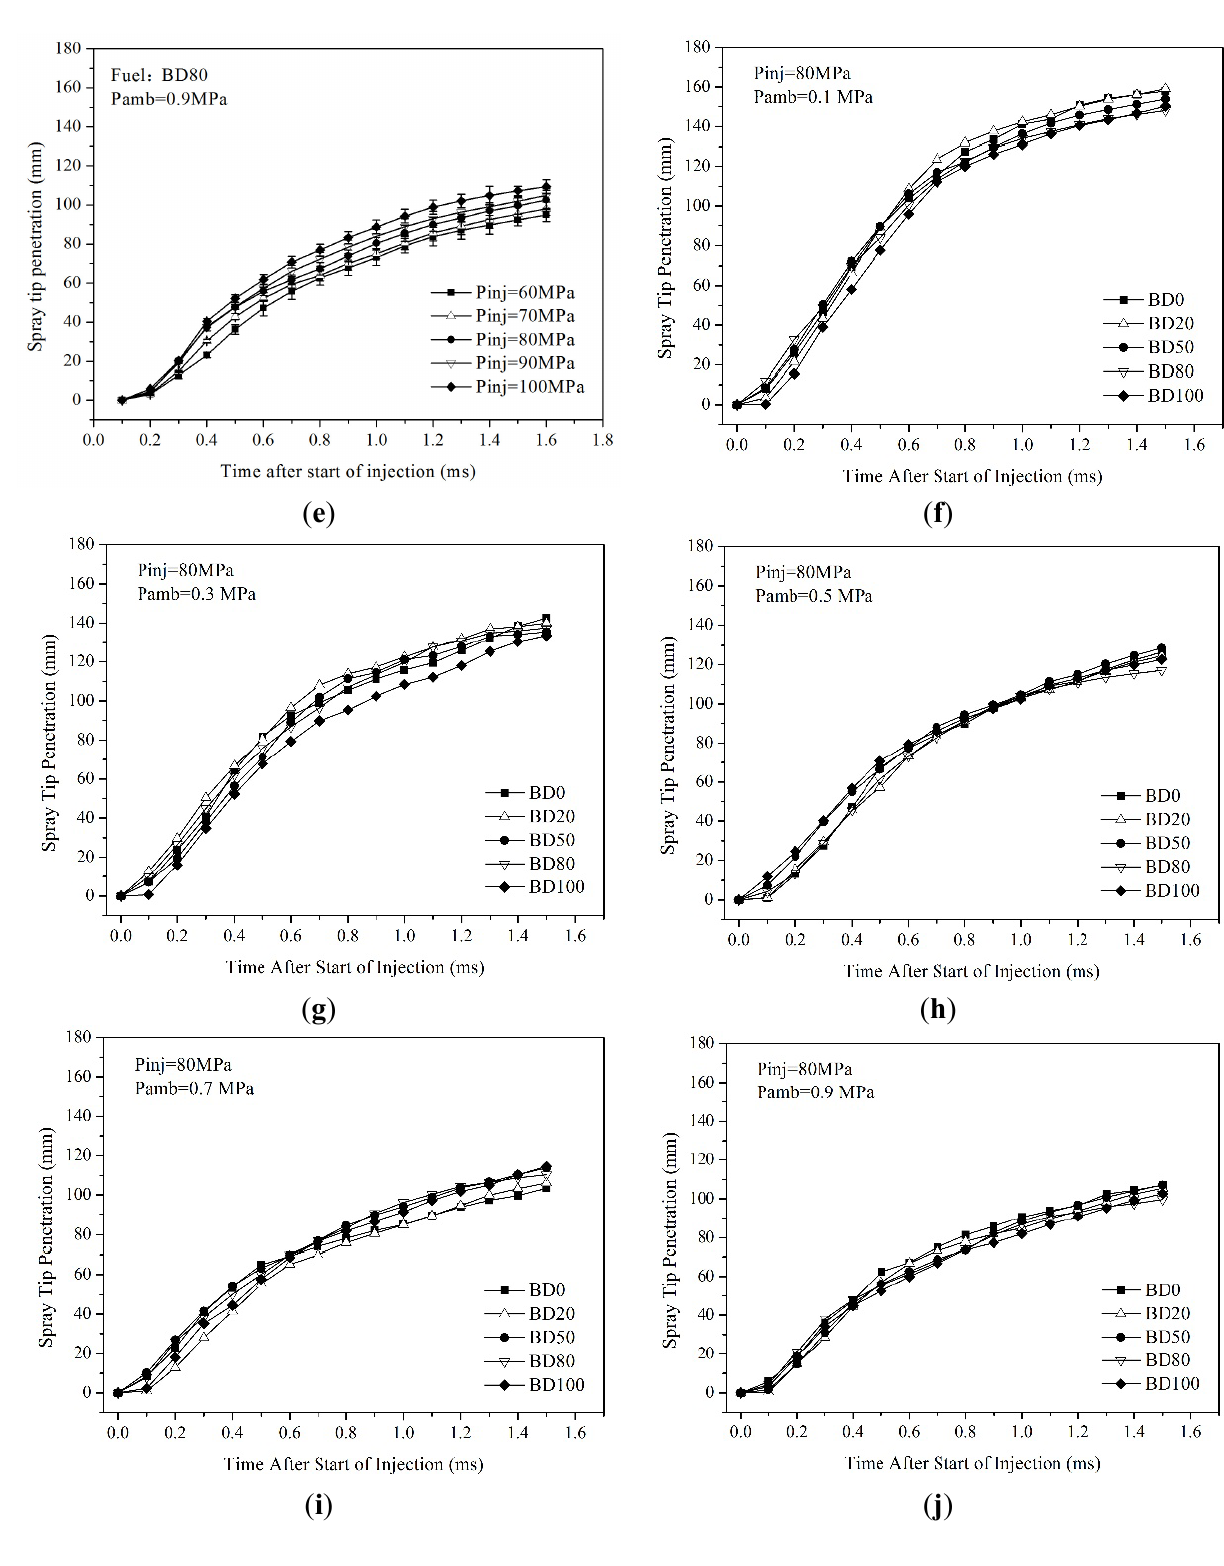
Figure 2. Spray tip penetration for different fuels under different ambient pressures. Spray tip penetration of BD80 at different injection pressures: ( a ) Pamb = 0.1 MPa; ( b ) Pamb = 0.3 MPa; ( c ) Pamb = 0.5 MPa; ( d ) Pamb = 0.7 MPa; ( e ) Pamb = 0.9 MPa. Spray tip penetration of different fuels at injection pressure 80 MPa: ( f ) Pamb = 0.1 MPa; ( g ) Pamb = 0.3 MPa; ( h ) Pamb = 0.5 MPa; ( i ) Pamb = 0.7 MPa; ( j ) Pamb = 0.9